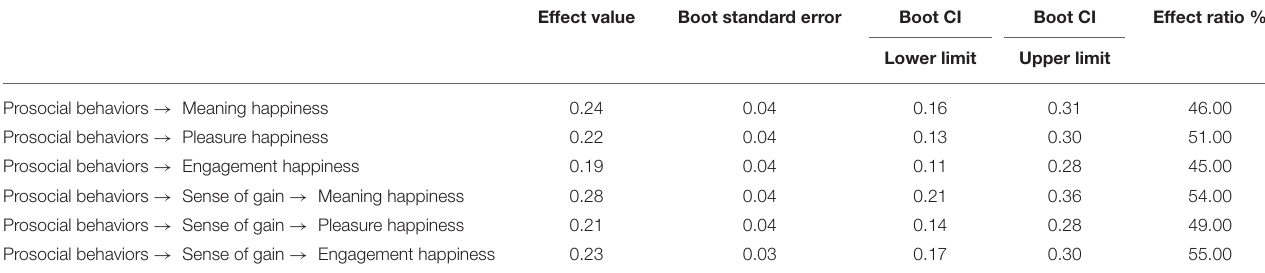
TABLE 4 | Bootstrap analysis of moderated mediation